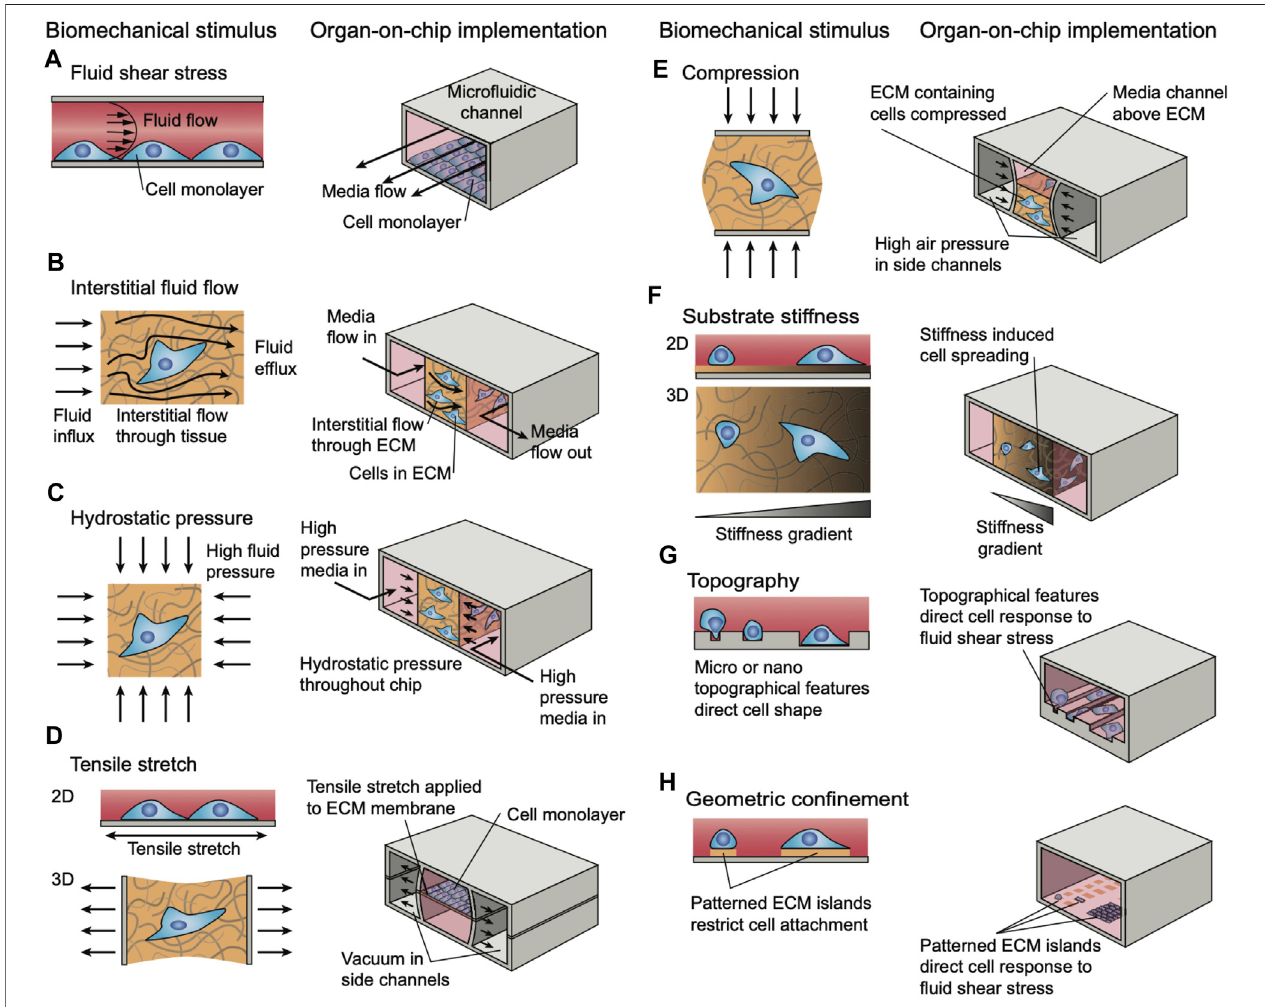
FIGURE 7 | Strategies for simulating different modalities of biomechanical loading and stimuli in microphysiological systems. Reproduced from (Thompson et al., 2020) under the Creative Commons Attribution License (CC BY).